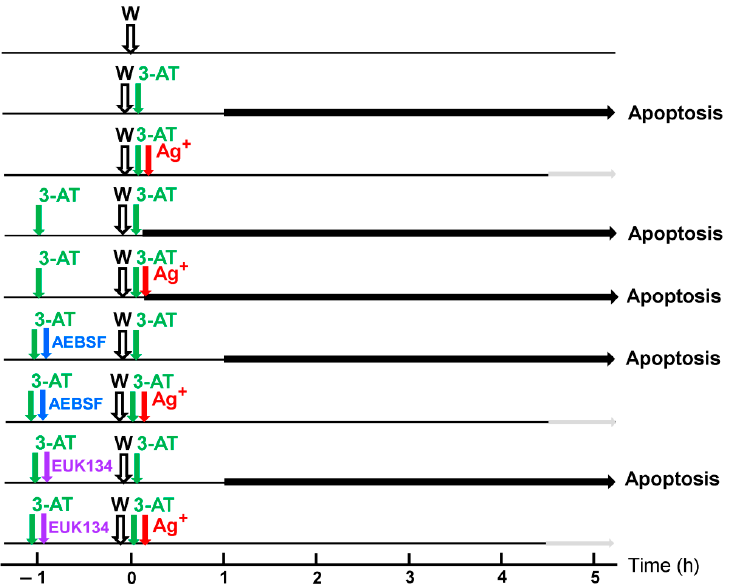
Figure 5. The sensitizing effect mediated by aquaporins requires extracellular H 2 O 2 generated through dismutation of NOX1-derived superoxide anions. The principle of this experiment was the division of treatment of the cells in a pretreatment time of 1 h ( − 1 until 0 h in the graph) followed by three washing steps (“W”) and subsequent continuation of treatment in 96 well plates (12,500 cells/assay). Compounds present during pretreatment or after the washing step are indicated in the legend incorporated into the graph. The following concentrations were used: 3-AT: 100 mM; Ag+: 5 µM; AEBSF: 100 µM; EUK-134: 20 µM. The percentages of apoptotic cells were determined kinet- ically. ( B ): The data confirm that catalase inhibition is necessary for apoptosis induction. Pretreat- ment without 3-AT, followed by 3-AT treatment after the washing step (0/W/3-AT) resulted in an